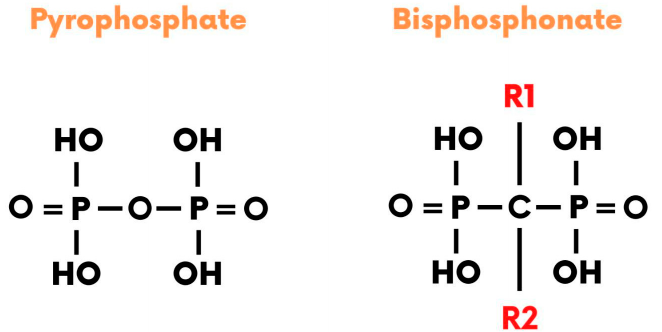
Figure 2. Chemical formula of pyrophosphate to BPs.